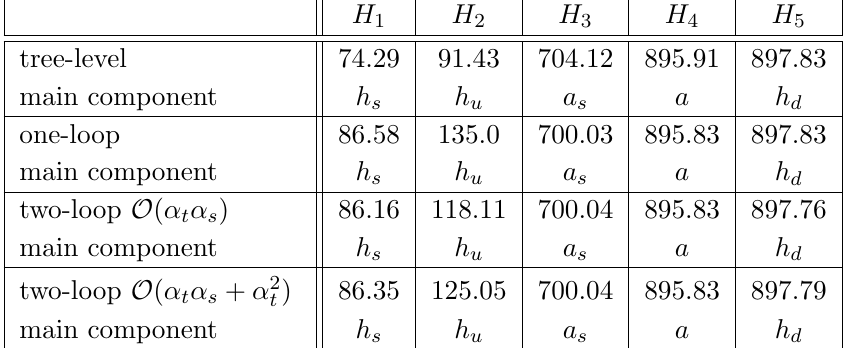
) obtained by using OS renormalization t